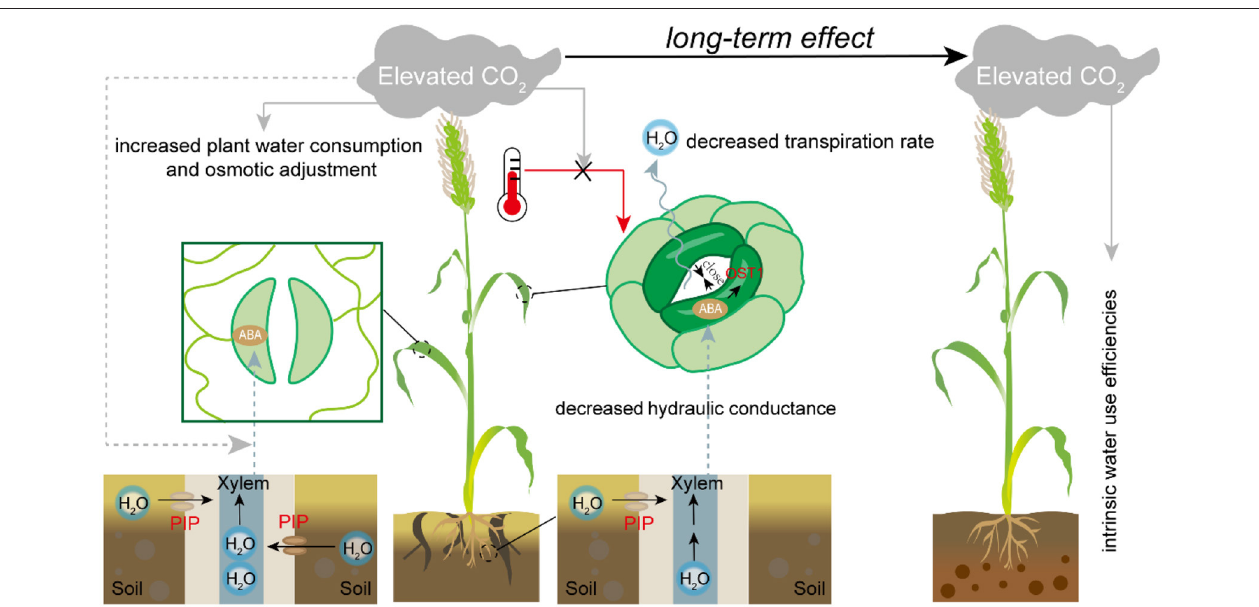
FIGURE 1 | The roles of stomata and its relationships with other physiological processes in the responses to interactions of e [CO 2 ], drought, and/or heat stress. The figure shows the modulation of stomatal response by e [CO 2 ] in plants under drought and heat stress. Under a warmer condition, e [CO 2 ] has no effect on stomatal opening; however, under drought stress the leaf and root hydraulic conductance, as well as transpiration rate, are decreased, which is coupling with the modulated transcriptional levels of PIPs and OST1 . However, some PIPs are not influenced by e [CO 2 ], thereby triggering the possibility that e [CO 2 ] disturbs ABA-mediated drought responses. In addition, the long-term e [CO 2 ] significantly influence the WUE i in the first filial generation.